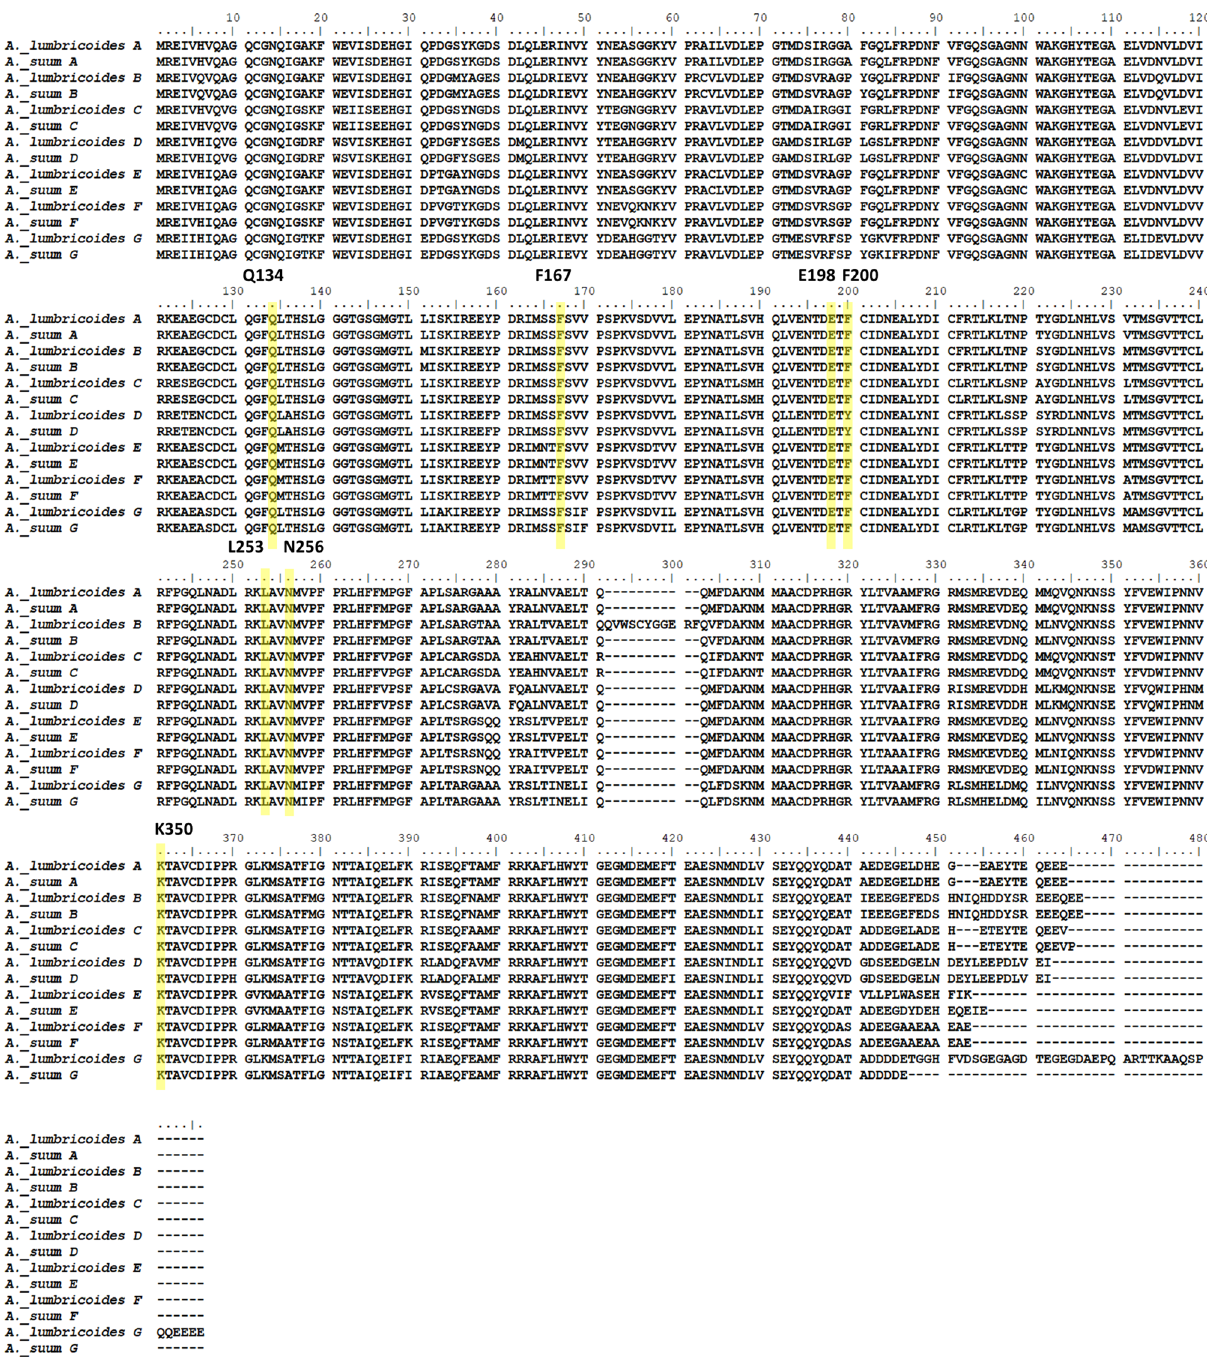
Figure 2. Representative amino acid alignment of Ascaris β-tubulins. Alignments for each Ascaris β-tubulin isotype used in docking simulations. The common resistance associated amino acids (F167, E198 and F200Y) and the amino acids that were found to interact with BZs (Q134, L253, N256 and K350) and may be of some importance are highlighted in